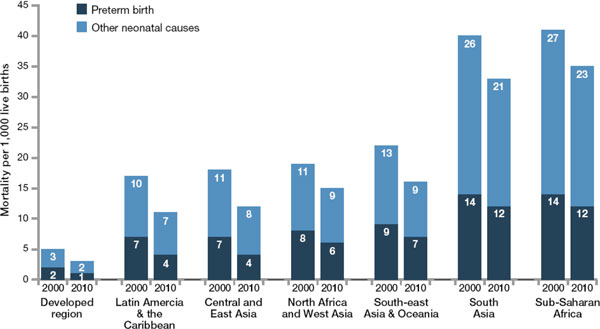
Increasing survival gap for preterm babies around the world: Regional variation in preterm birth as direct cause of neonatal deaths showing change between 2000 to 2010. Source: Born Too Soon, Chapter 5 [113]. Data from Child Health Epidemiology Reference Group and World Health Organization estimates of neonatal causes of death (Liu et al. 2012) [8].